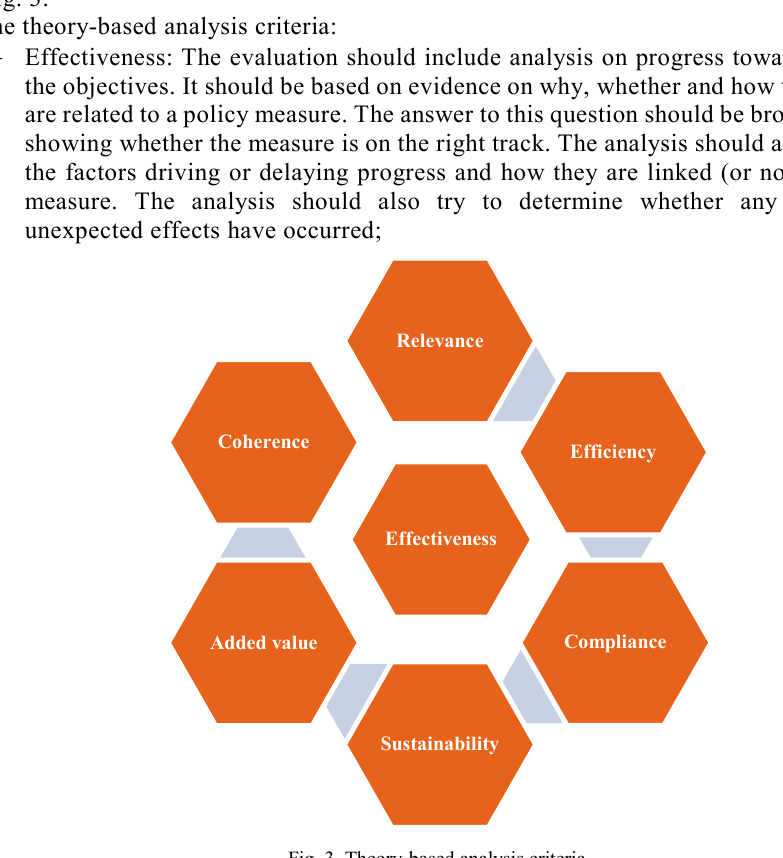
Fig. 3. Theory-based analysis